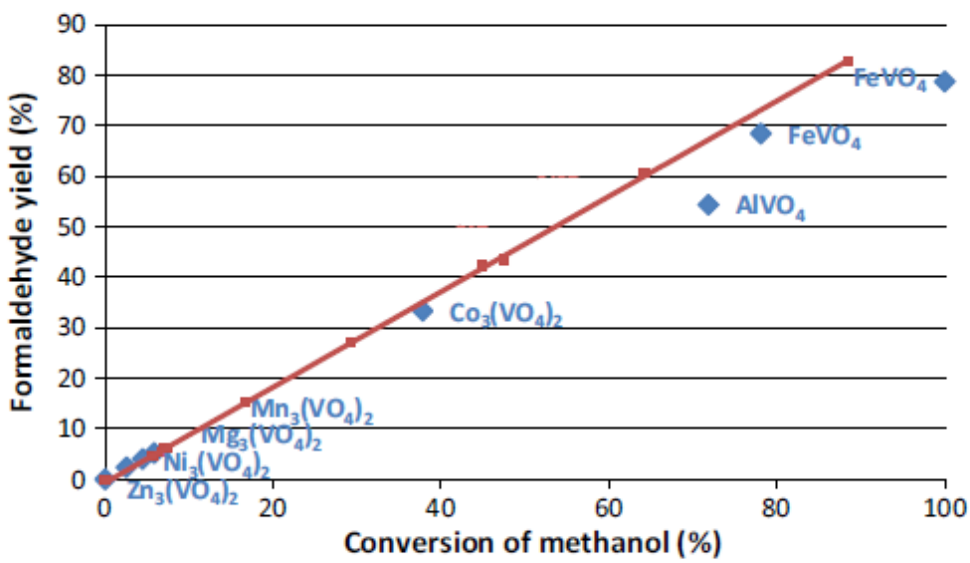
Figure 1. Comparisons of the yield and conversion of formaldehyde over the various vanadates in the Formox (oxide ‐ based catalyst) process. Reprint from [99]. Copyright (2021) from Springer Na ‐ ture